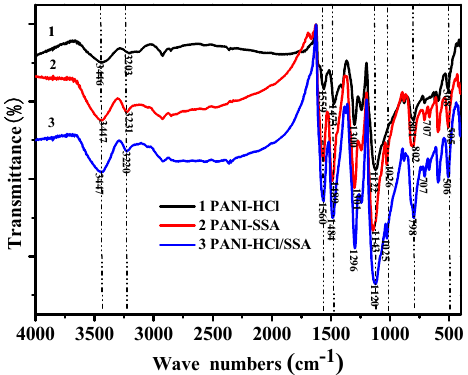
Figure 2. FTIR spectrum of different acid-deposited PANI.